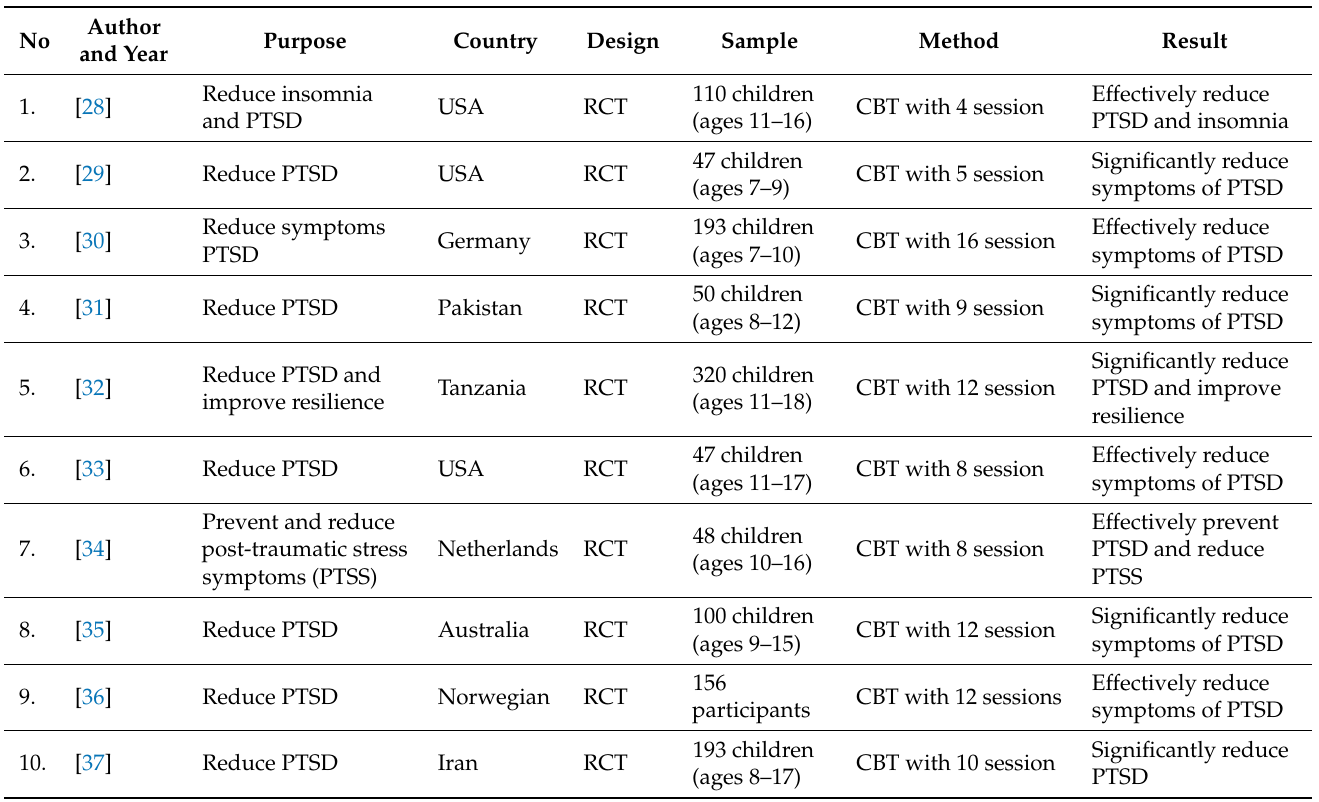
Table 2. Extraction